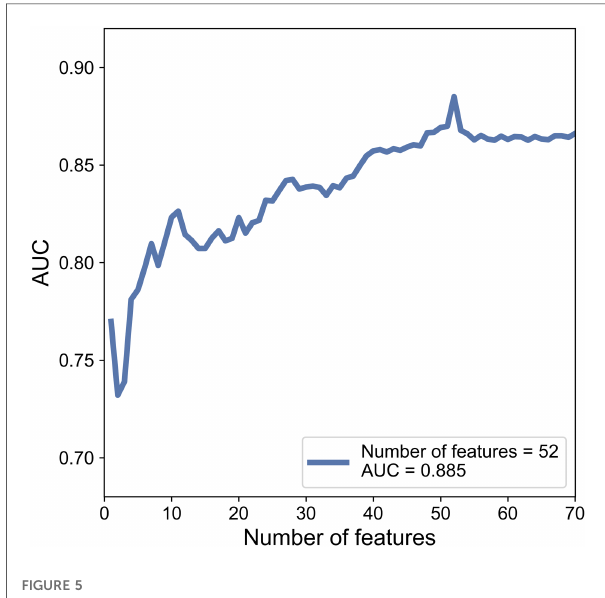
FIGURE 5 The change of AUC with the number of features.